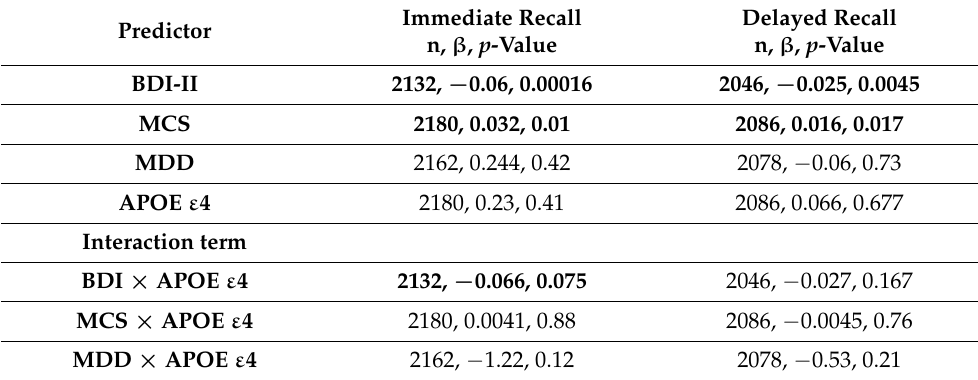
Table 4. Direct effects and interaction results for depression variables and APOE4 status on the endpoint verbal memory (VLMT) in LEGEND for covariate set 1.